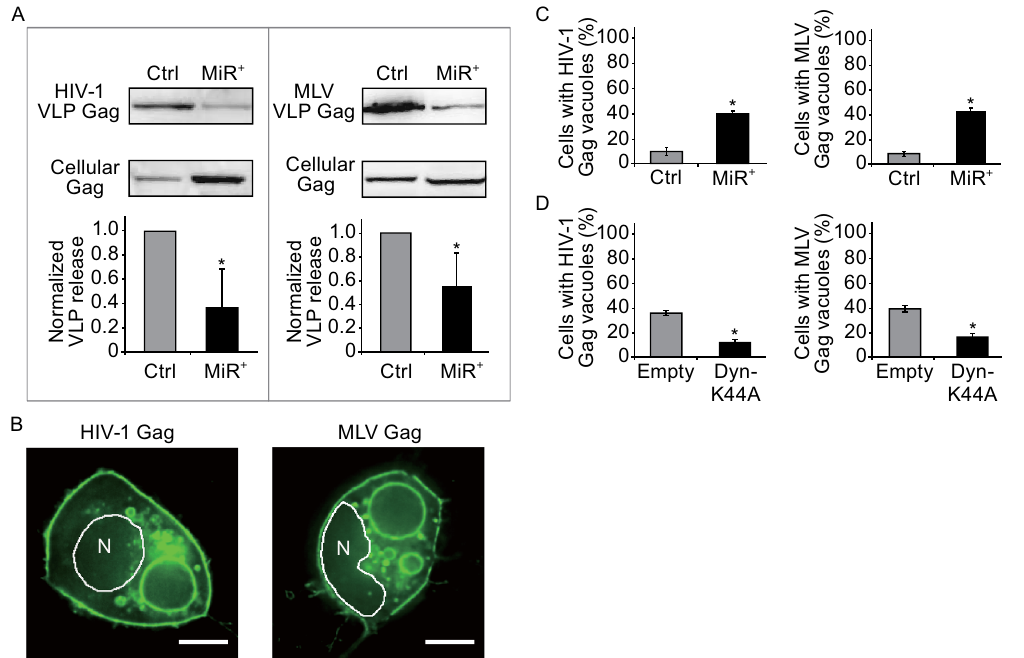
Figure 4. The effects of overexpressing non-silencing miRNAs on Gag assembly and intracellular localization of various retroviruses. (A) The effect of overexpressing non-silencing miRNAs on VLP production by MiR + and Ctrl cells transfected with CMV- driven plasmids encoding HIV-1 or MLV Gag proteins. Results were normalized to virus release ef fi ciency in Ctrl cells. (B) Representative images of HIV-1 or MLV Gag (detected by Gag-EGFP) in MiR + cells. (C) Percentage of cells with large (diameter > 1 μ m) intracellular vacuoles enriched in Gag after transfection of HIV-1 or MLV Gag. (D) Cells expressing HIV-1 or MLV Gag along with Dyn-K44A, a dominant-negative mutant that inhibits endocytosis, showed reduced Gag vacuole formation as compared with cells expressing an empty vector. Data represent mean ± SD of at least three replicates. For (C) and (D), each replicate experiment was performed by examining at least 200 transfected cells. Scale bar = 10